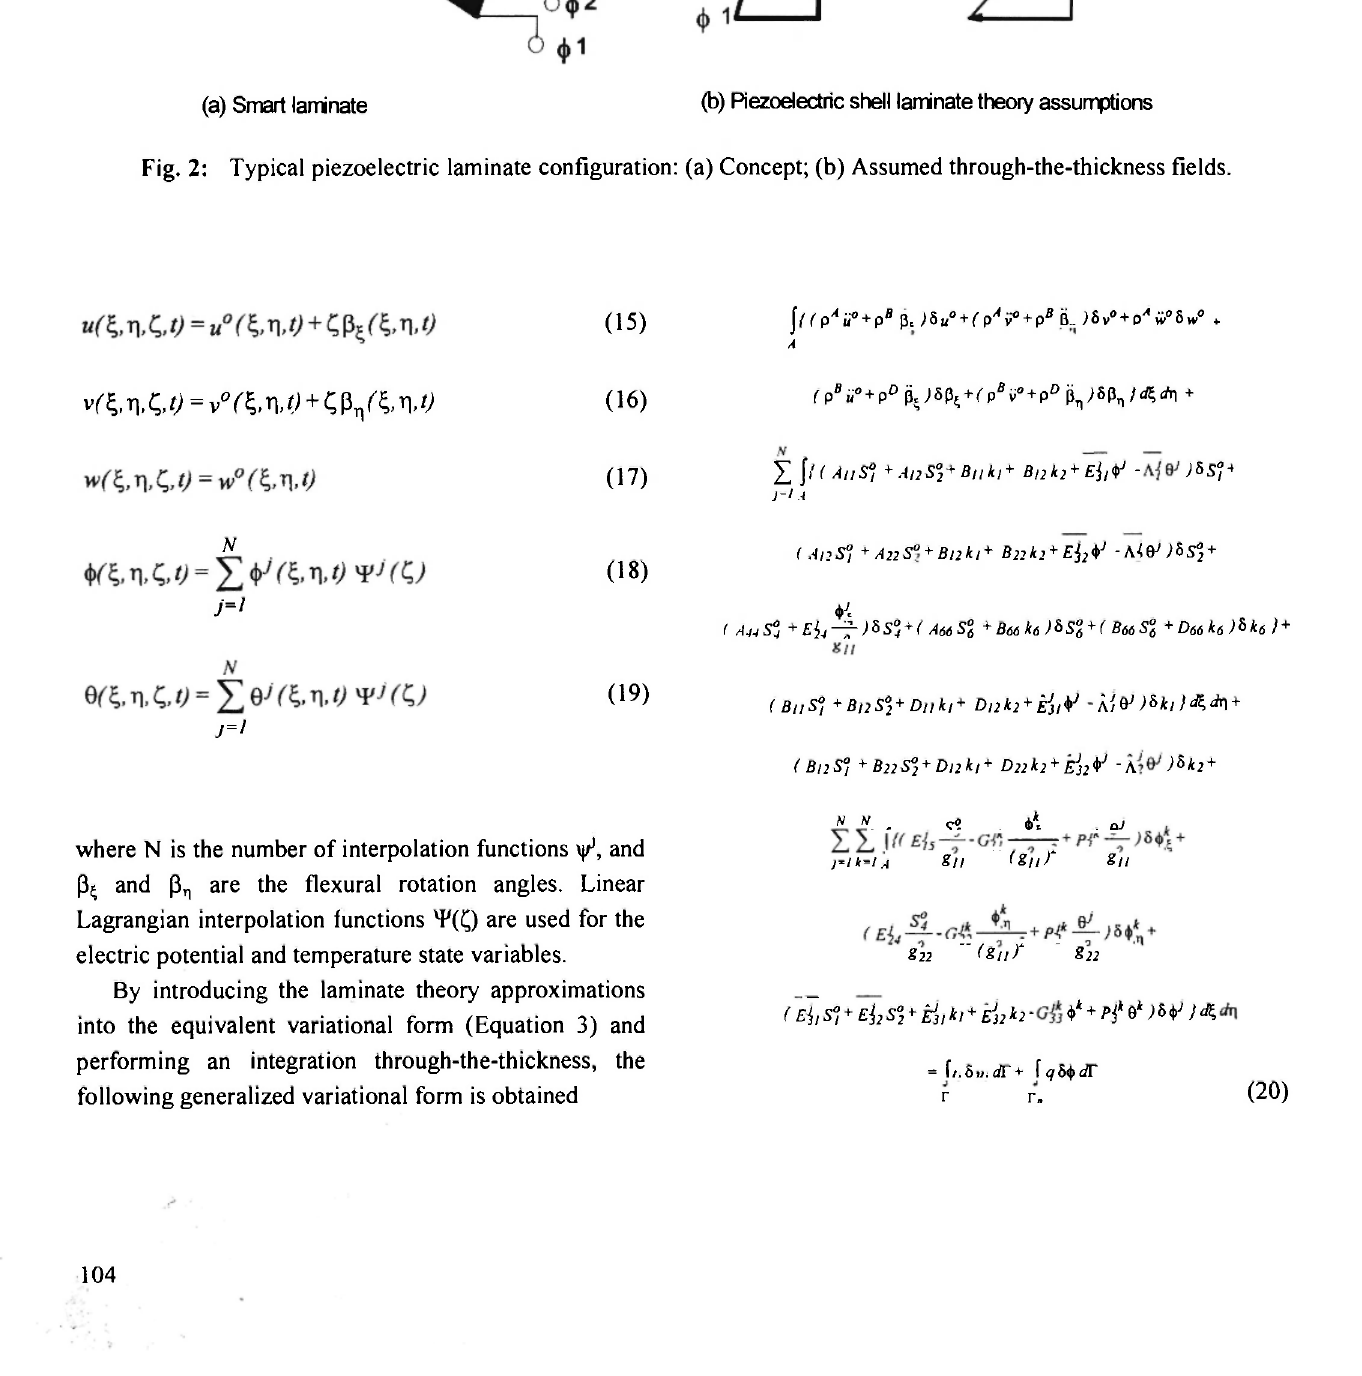
Fig. 2: Typical piezoelectric laminate configuration: (a) Concept; (b) Assumed through-the-thickness